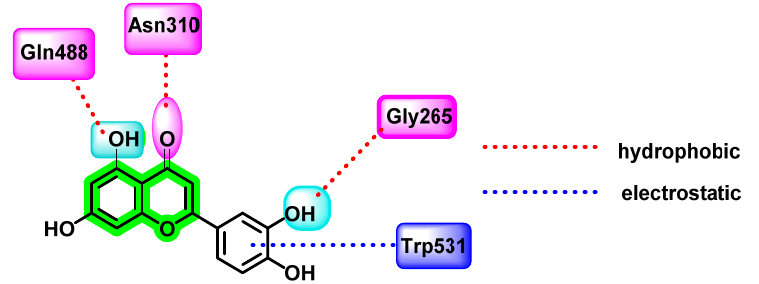
Figure 16. Luteolin complex with furin